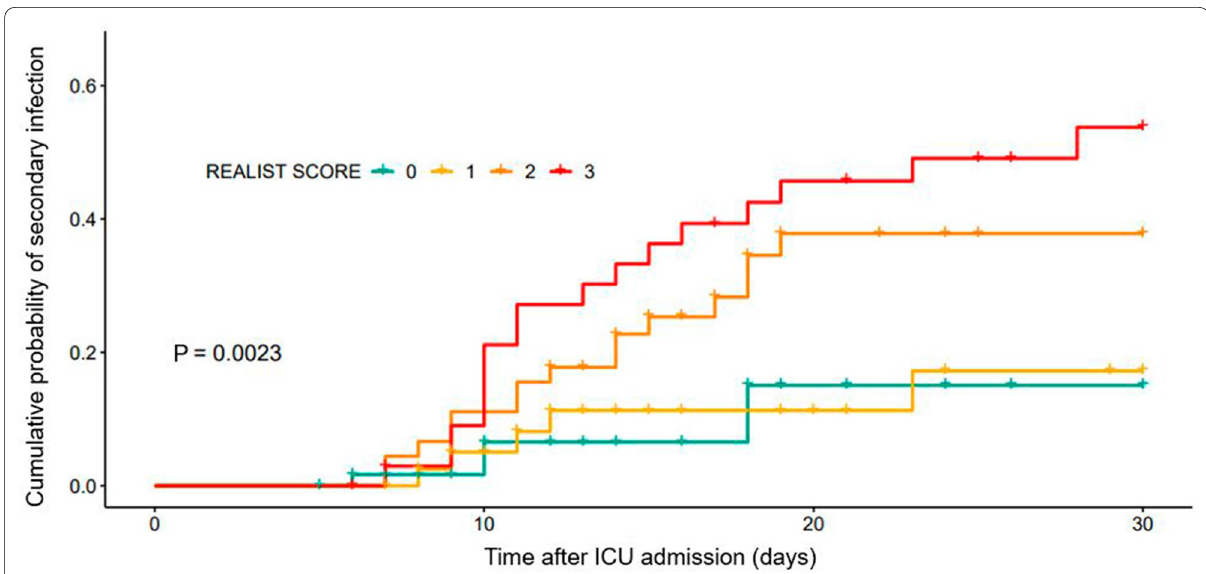
Fig. 1 REALIST score and subsequent cumulative probability of secondary infection in survivors. Computed from Cox proportional hazards model in the cohort of interest ( n 189 ICU patients at days 5–7) =